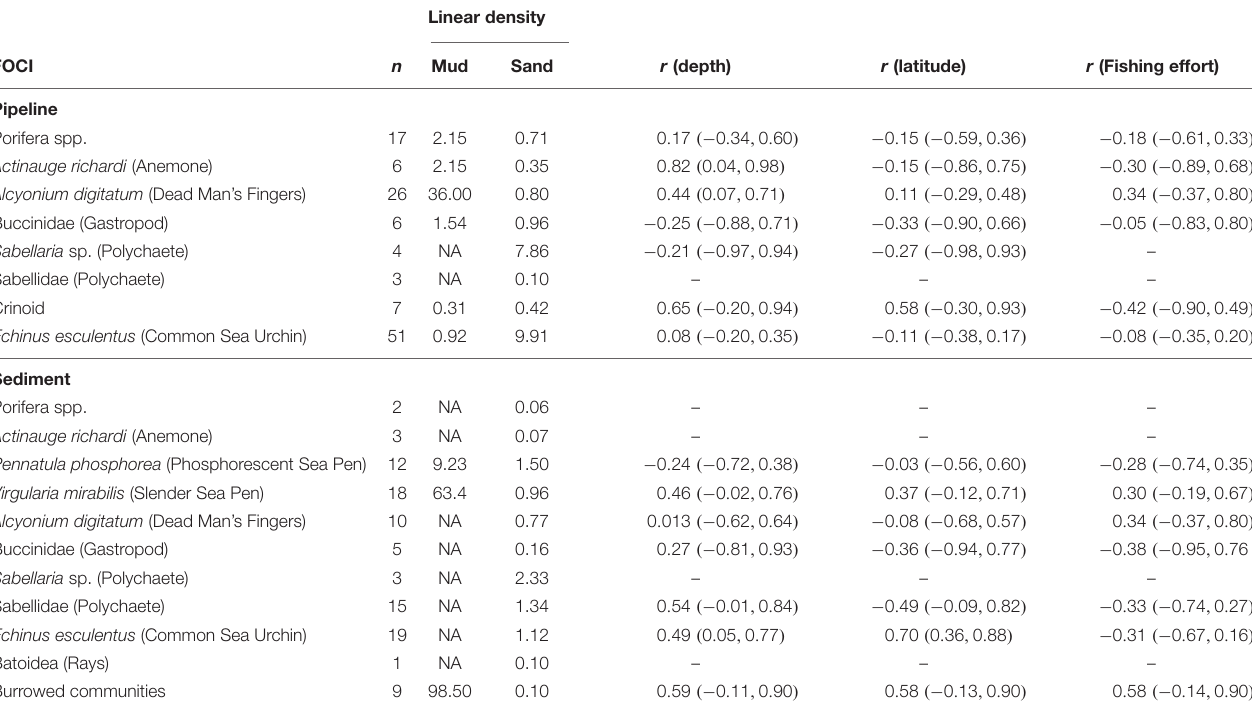
n indicates number of observations for entire survey, NA indicates no observations of the FOCI. r represents the Pearson’s correlation coefficient between FOCI density and depth, latitude or fishing effort. 95% confidence intervals for correlation coefficients are shown in brackets. Correlations coefficients were only calculated for FOCI where n > 3. Only quantified (FOCI) taxa are